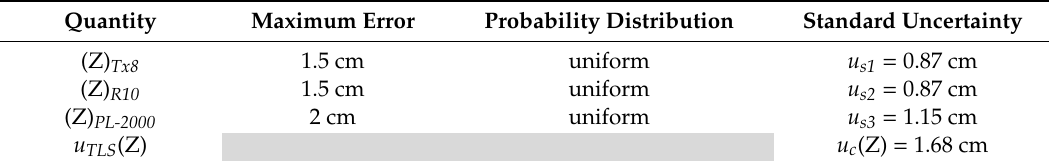
Table 2. Uncertainty budget (Z coordinate) of TLS